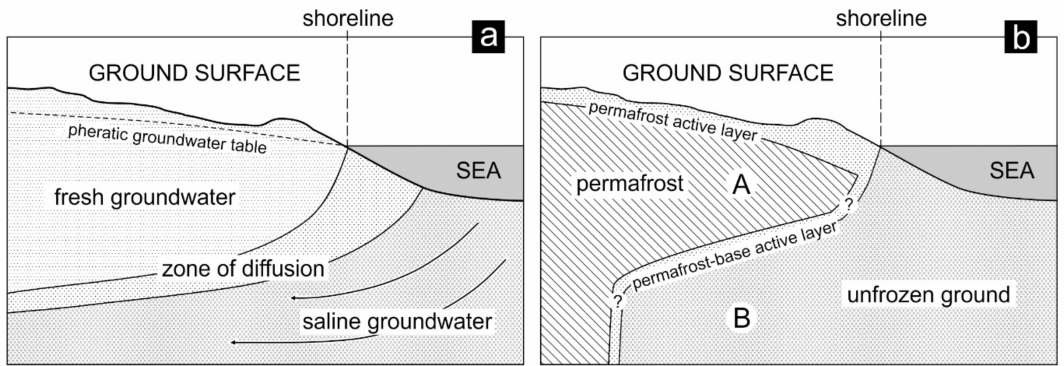
Figure 5. The onshore impact of sea water: ( a ) salt water intrusion in a coastal aquifer; ( b ) permafrost range limited by seawater, based on [1], A —“permafrost wedge”, B —seawater intrusion / heat wave e ff